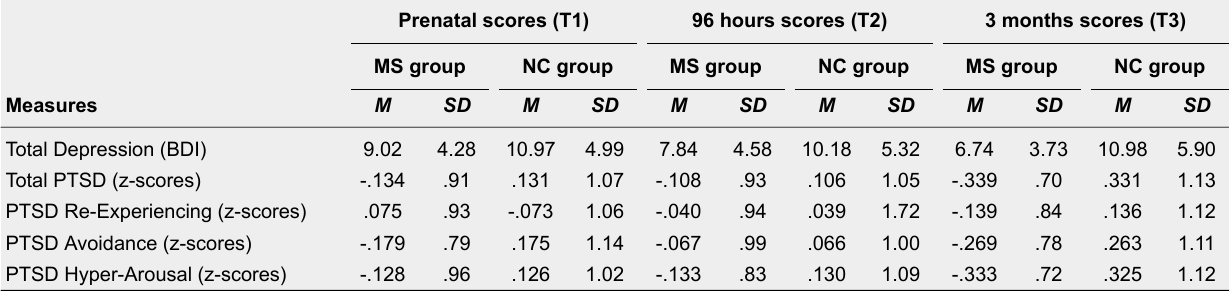
Descriptive Statistics for Depression and PTSD Symptoms at Prenatal, 96 Hours and 3 Months After Childbirth